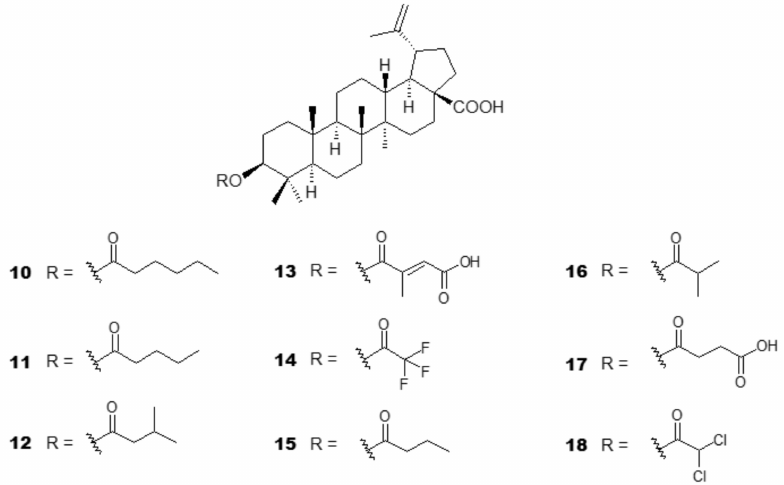
Figure 4. Antiplasmodial BA analogues from esterification at the C-3 OH group.